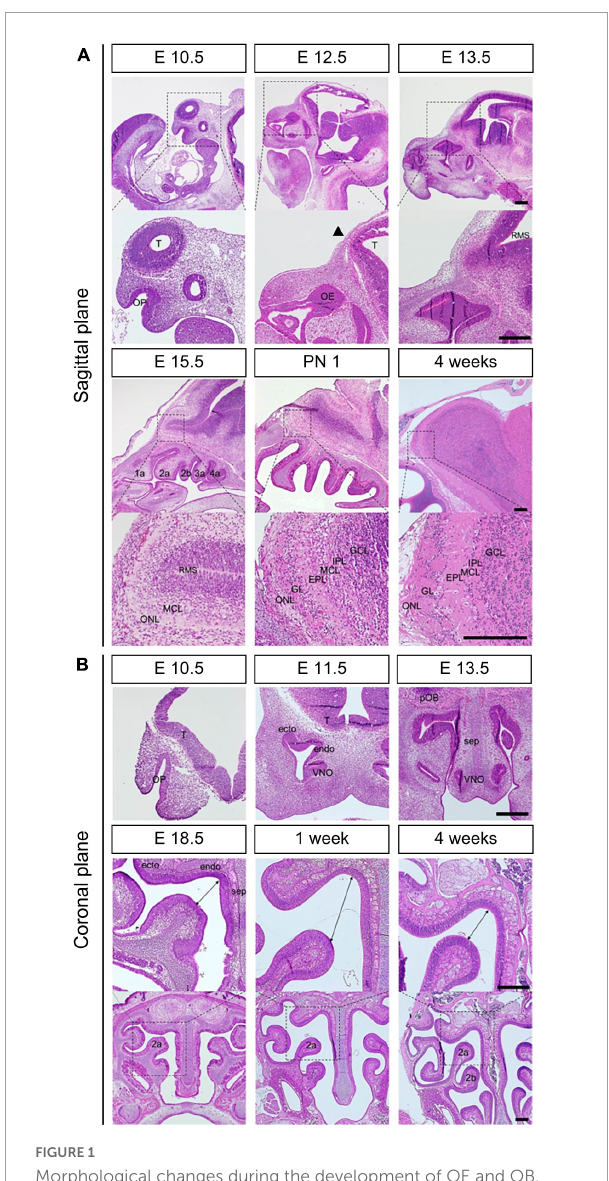
FIGURE1 Morphological changes during the development of OE and OB. H&E staining (A) in the sagittal direction at E10.5, E12.5, E13.5, E15.5, PN 1, and 4 weeks and (B) in the coronal direction at E10.5, E11.5, E13.5, E18.5, 1 week, and 4 weeks. Black arrow in the sagittal direction at E12.5 indicates the tip of the telencephalon. The double arrows at E18.5, 1 week, and 4 weeks in the coronal direction indicate the distance between the each end of olfactory turbinate. T, telencephalon; OE, olfactory epithelium; RMS, rostral migratory stream; OP, olfactory pit; endo, endoturbinate; ecto, ectoturbinate; VNO, vomeronasal organ; MCL, mitral cell layer; ONL, olfactory nerve layer; GL, glomerular layer; EPL, external plexiform layer; IPL, internal plexiform layer; GCL, granule cell layer. Scale bar, 250 µ m.